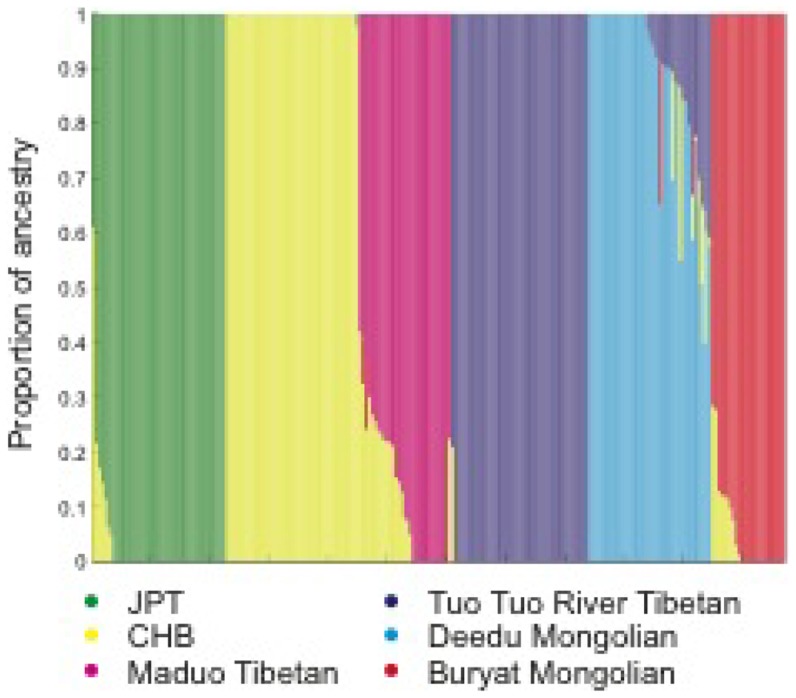
Population structure of Tibetans and neighboring populations.Individual grouping inferred by Admixture with k = 6, arranged by population. Each vertical bar represents an individual's genome. The colors correspond to the proportion of an individual's ancestry derived from one of the k groups.